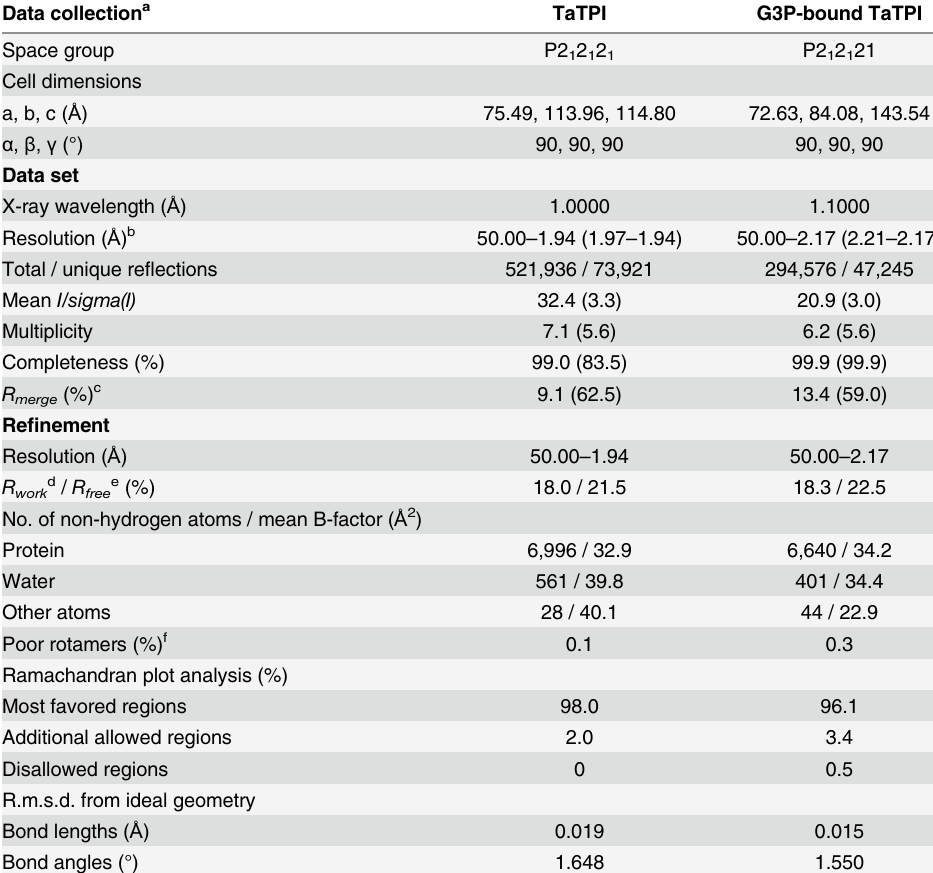
Table 1. Statistics for data collection, phasing, and model